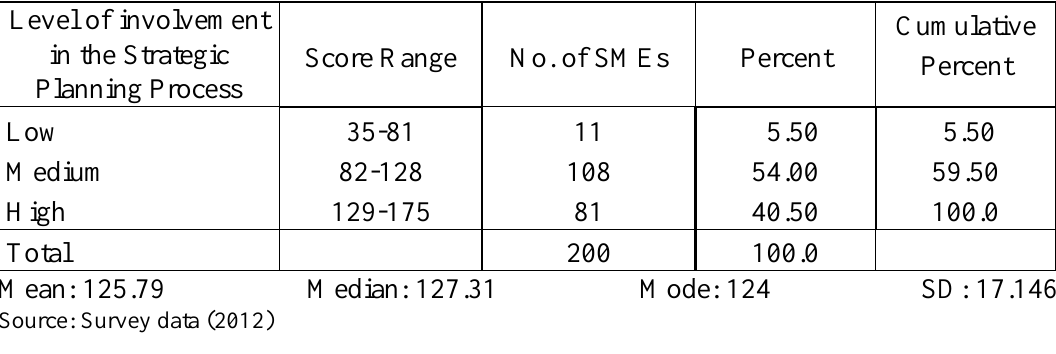
Table 8: SMEs by Level of Involvement to the Strategic Planning Process Level of involvement in the